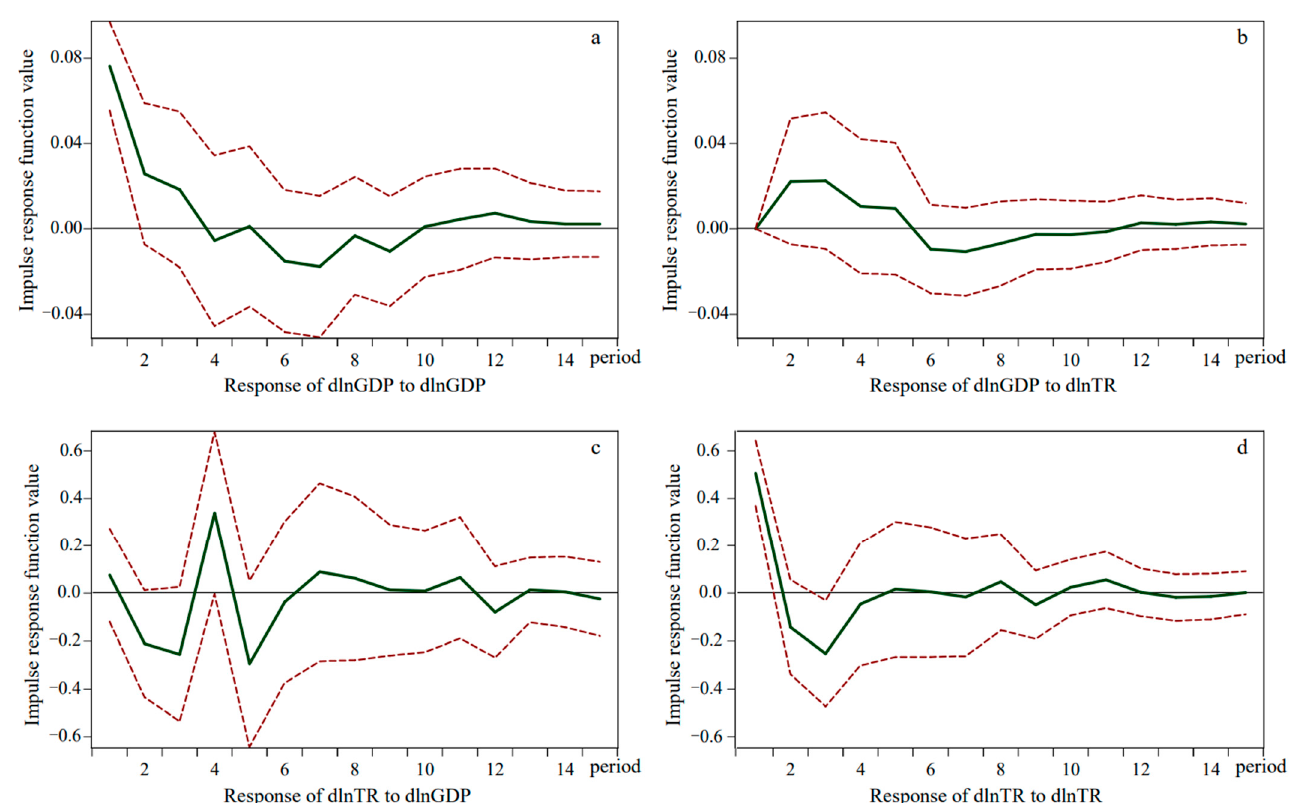
Figure 4. Results of impulse response function of VAR(4) model. The solid green line indicates the movement of the variable after a shock, and the top and bottom red lines indicate deviation bands of plus or minus two times the standard deviation. Subfigures a and b indicate that the economic growth rate of Ganzi Prefecture is subject to shocks from itself and the growth rate of the compre- hensive tourism revenue of the Hailuogou scenic spot, respectively. Subfigures c and d show that nomic growth rate shock of Ganzi Prefecture and its own shock,